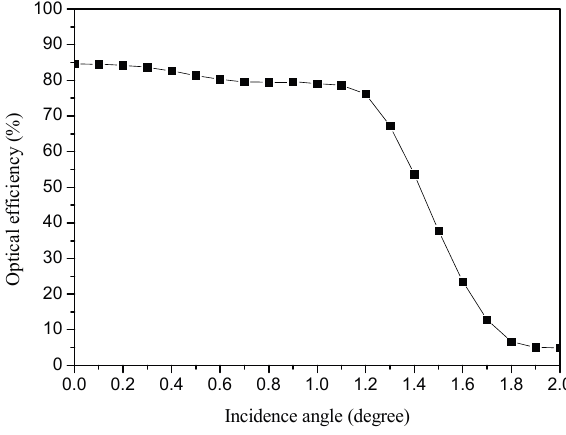
Figure 2. Optical efficiency of the Fresnel lens with KOD-type SOE.